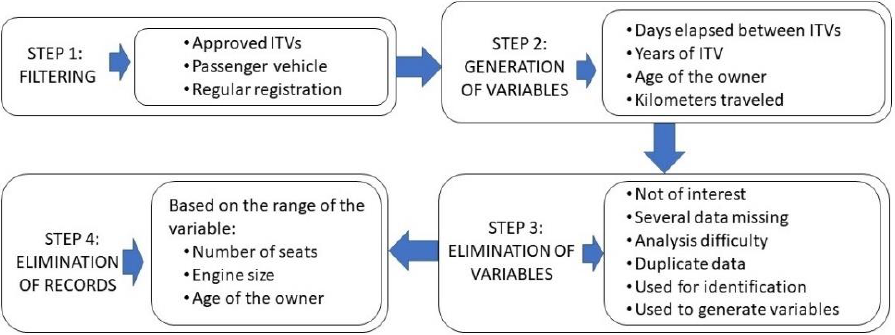
Figure 2. Data processing methodology.